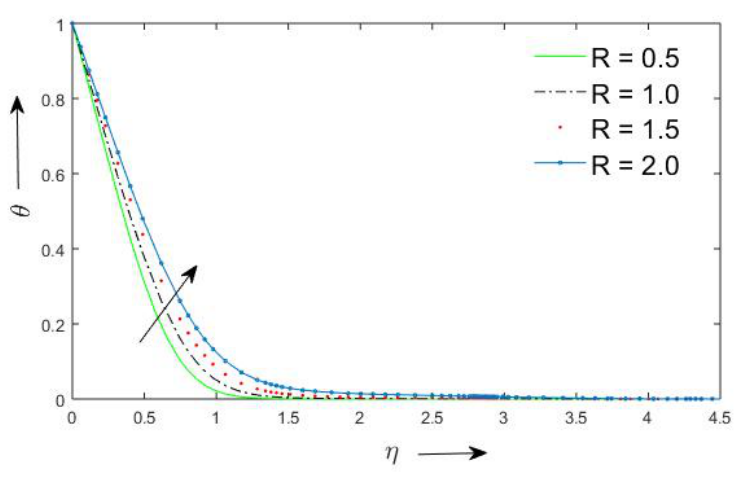
Figure 11: Changes in temperature as a consequence of R